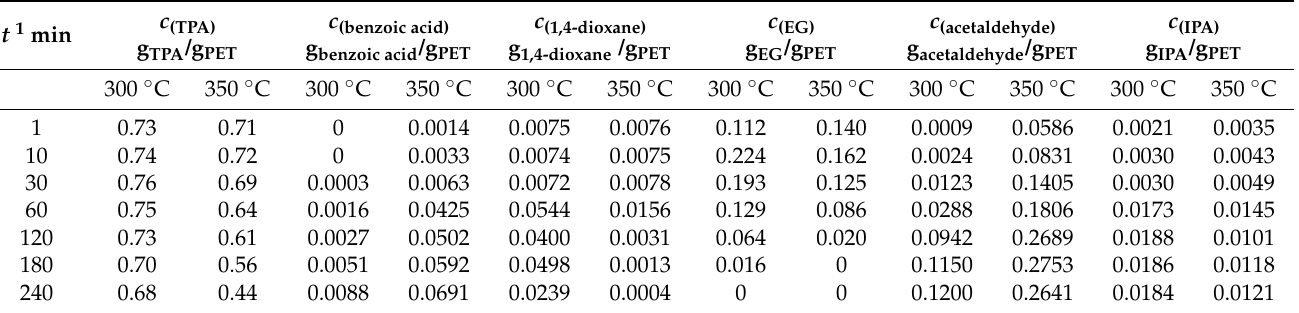
Table 2. Concentration of degradation products (g component /g material ) of colorless PET waste in